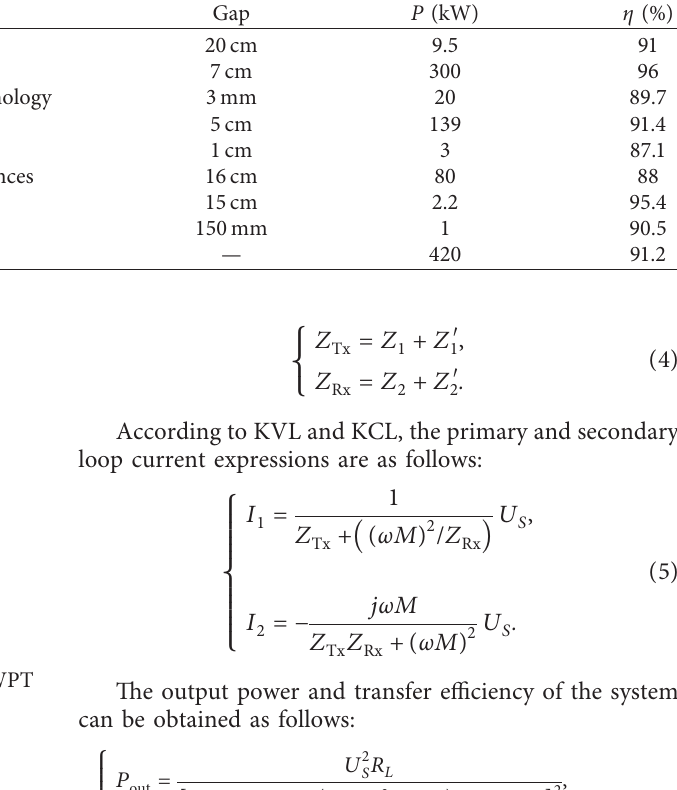
Table 1: System parameters.